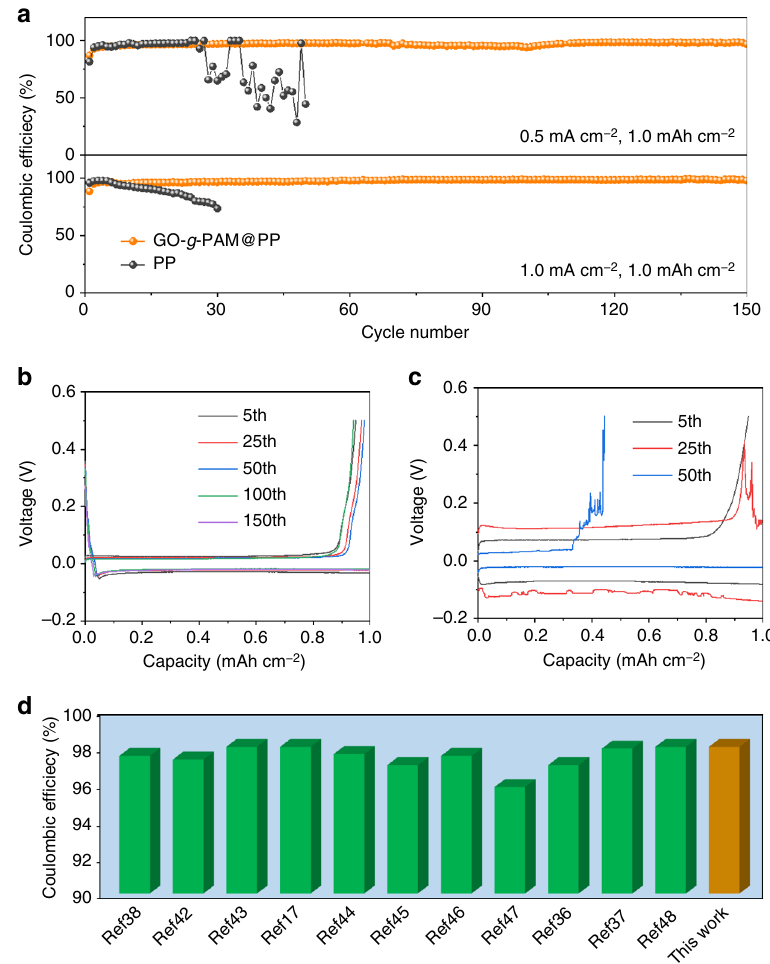
Fig. 4 Electrochemical performance of Li|Cu cells with GO- g -PAM@PP and PP separators. a Coulombic ef fi ciencies of Li|Cu cells with GO- g -PAM@PP and PP separators with a cycling capacity of 1 mAh cm − 2 at various current densities. Voltage pro fi les of Li plating/stripping processes in Li|Cu cells with ( b ) GO- g -PAM@PP and ( c ) PP separators with a cycling capacity of 1 mAh cm − 2 at 0.5 mA cm − 2 . d Average Coulombic ef fi ciency of a Li|Cu cell with GO- g -PAM@PP separator tested with a current density of 1 mA cm − 2 , compared with that of previously reported asymmetric cells with Li metal